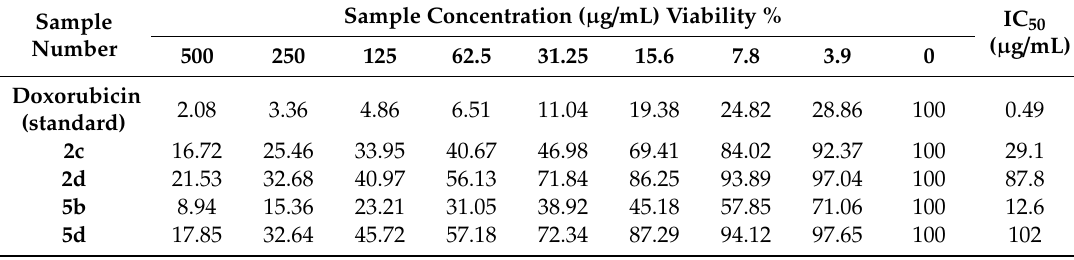
Molecules 2019 , 24 , x Table 6. Viability values and IC 50 of assessed thiazolines and Doxorubicin against colon carcinoma cells (HCT-116) Cell Line.